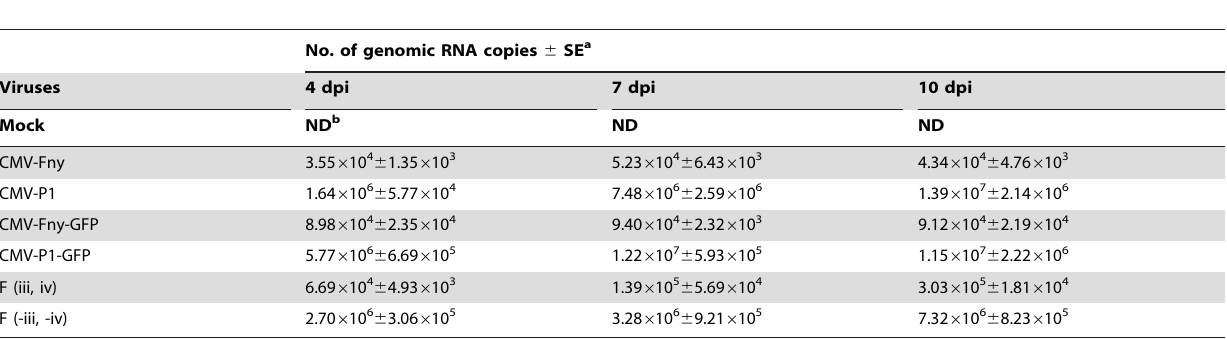
Table 3. Quantification of the genomic RNA copies CMV-Fny, CMV-P1 and chimeric viruses in inoculated leaves of C. annuum